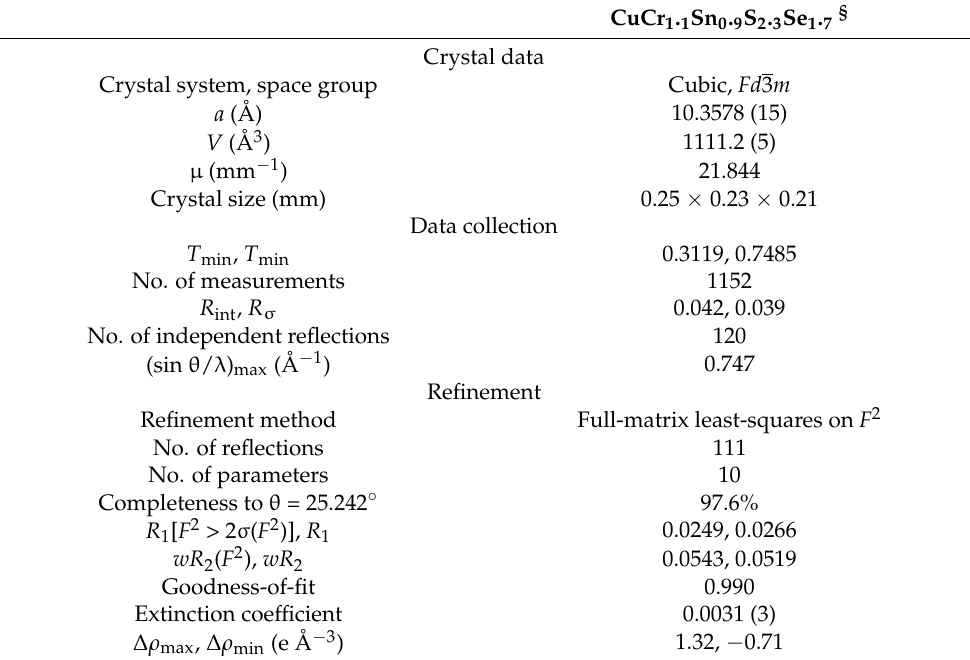
Table 1. Crystallographic data and structure refinement